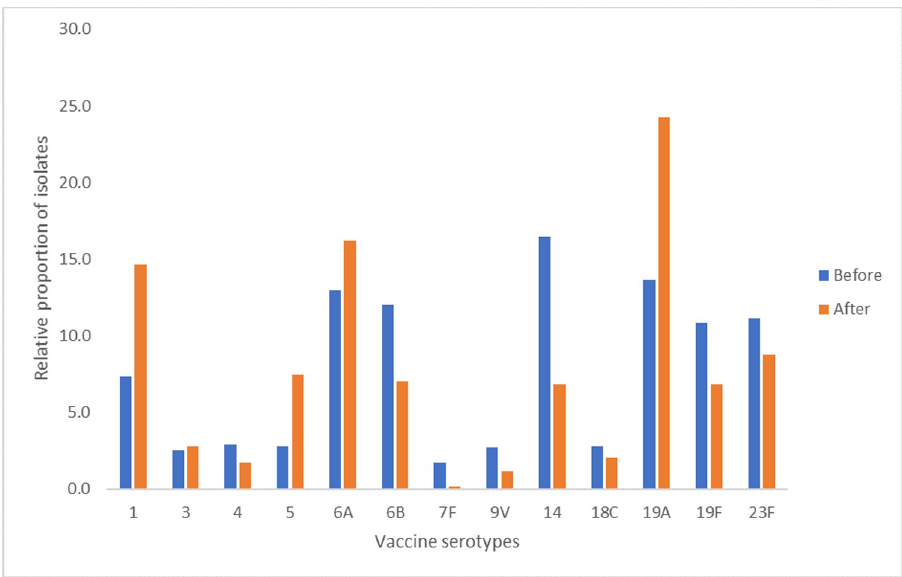
Fig 2. Relative proportion of vaccine serotypes before and after vaccine roll out. Following vaccine roll out, the relative proportions of serotype 1 (7.4%, n = 97 vs 14.6%, n = 100), 5 (2.8%, n = 37 vs 7.5%, n = 51) and 19A (13.7%, n = 180 vs 24.3%, n = 166) doubled compared to the baseline measurement. In contrast, a significant reduction in serotypes 14 (6.9% vs 16.5%), 6B (7.0% vs 12.0%) and 9V (1.2% vs 2.7%) was observed.